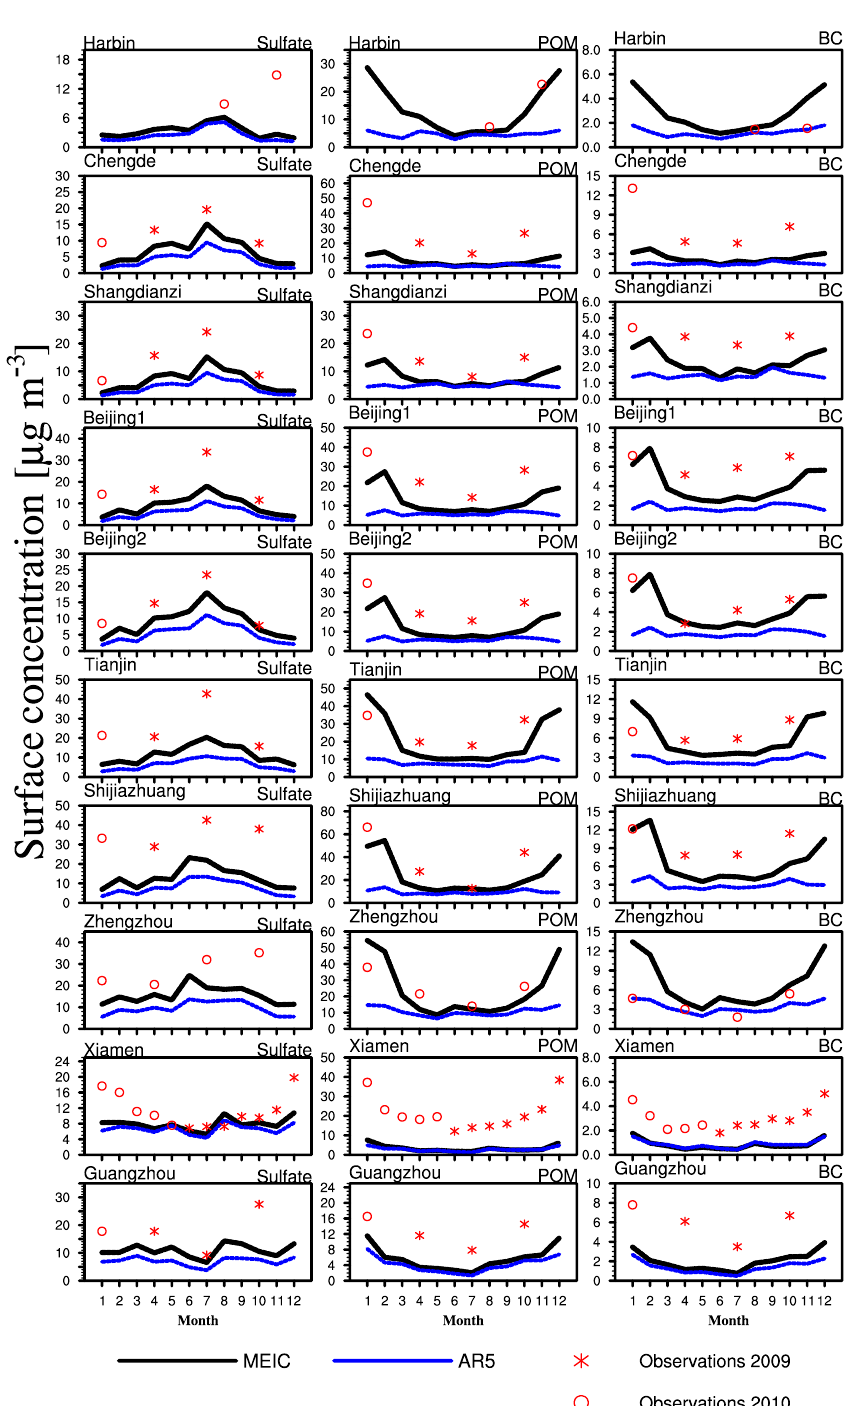
Figure 8. The seasonal variations of monthly-average surface concentrations of sulfate, POM, and BC modeled by CAM5-MAM3 using the MEIC (black lines) and the AR5 emissions (red lines) for the year 2009 compared with the observations (asterisks for 2009 and hollow circles for 2010). Error bars stand for 1 standard